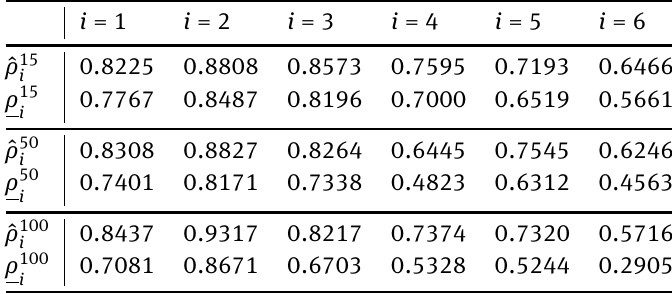
between the T -days log-returns of the i -th underlying asset and the DAX estimated i ) = 15 , T = 50 resp. T = 100 trading days; ρ T , x 0 k over T days for T k k under a bivariate normality i